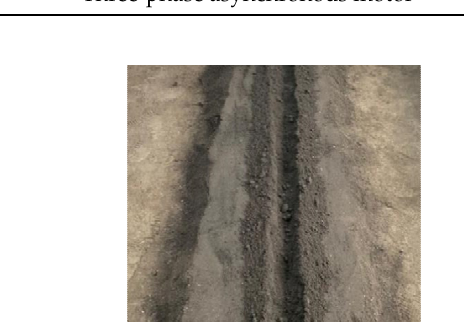
Figure 12. Soil bin experiment furrow .